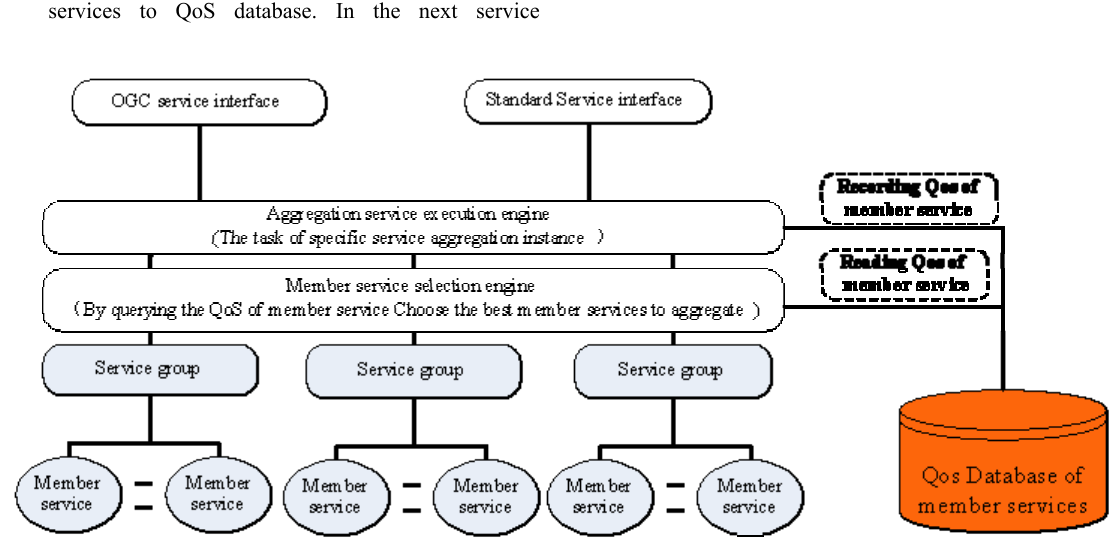
Fig.2. Logic diagram of Quality evaluation model of aggregation service implementation mechanism